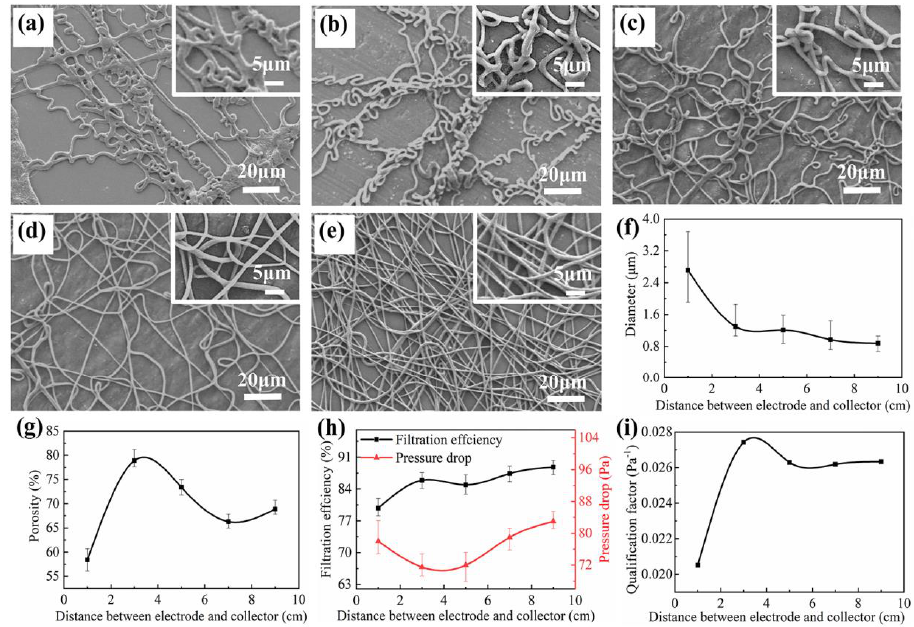
Figure 5. The SEM image of nanofibrous membrane and filtration performance with different distance between electrode and collector. ( a – e ) SEM image of PVDF nanofibrous membrane at the distance between electrode and collector of 1.0 cm, 3.0 cm, 5.0 cm, 7.0 cm and 9.0 cm, respectively; ( f – i ) diameter, porosity, filtration efficiency and pressure drop, QF of PVDF nanofibrous membrane at different distance between electrode and collector, respectively. The voltage, the roller speed and the electrospinning time was 5 kV, 50 rpm and 60 min, respectively.